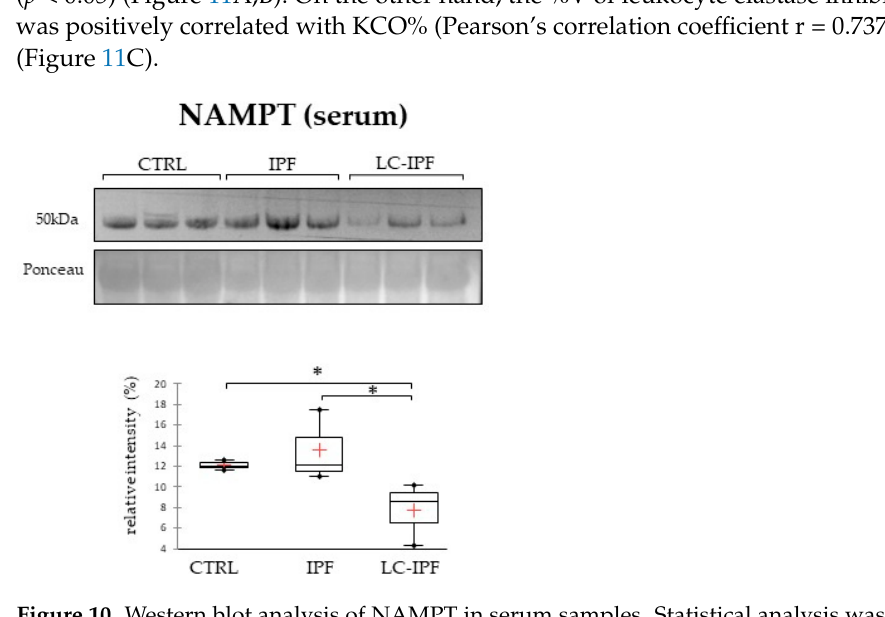
Figure 10. Western blot analysis of NAMPT in serum samples. Statistical analysis was performed by Kruskal–Wallis test and Dunn correction and reported in the box plots for CTRL–IPF–LC-IPF ( ∗ p -value ≤ 0.05). Ponceau red is reported to assure the equal loaded amount of sample. Samples used were three for CTRL, three for IPF, and three for LC-IPF. Moreover, we evaluated whether KCO% (approximately kCO/barometric pressure in mL/min/mmHg/L) is correlated with the %V of significant proteins detected by prote- omics. PROF1 and Rho GDP-dissociation inhibitor 1 (GDIR1) were negatively correlated with KCO% (Pearson’s correlation coefficients r = − 0.744; r = − 0.770, respectively) (p < 0.05) (Figure 11A,B). On the other hand, the %V of leukocyte elastase inhibitor (ILEU) was pos- itively correlated with KCO% (Pearson’s correlation coefficient r = 0.737) (p < 0.05) (Figure 11C).